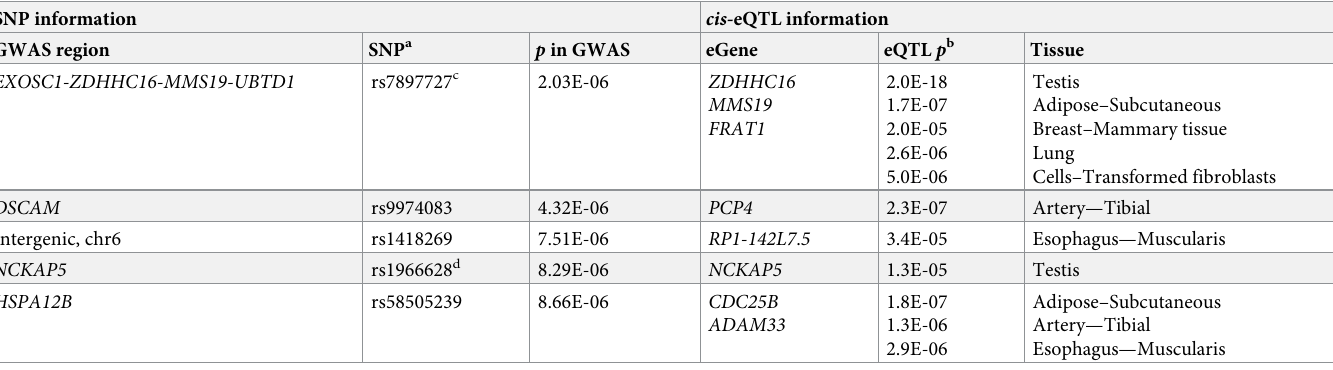
Table 3. Suggestively associated SNPs that overlap with cis